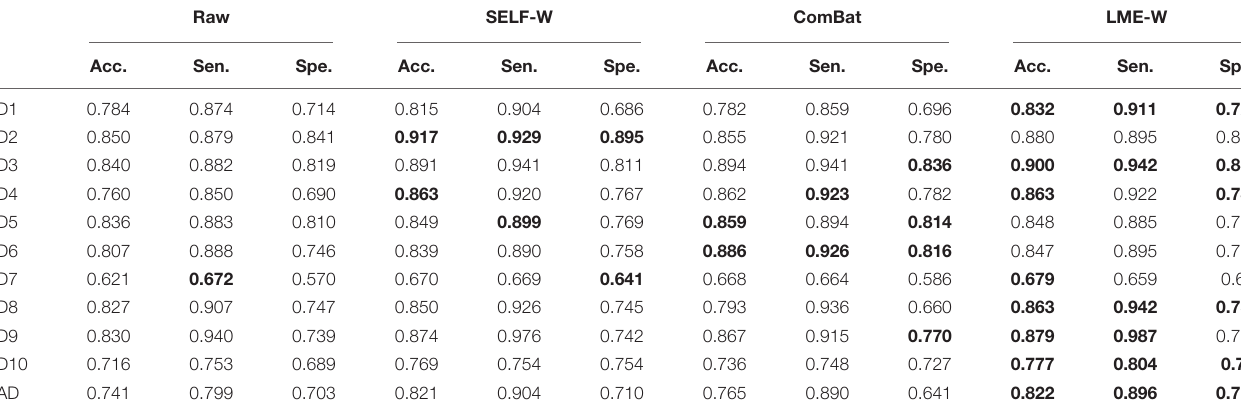
The bolded values show the highest performance in the corresponding dataset.